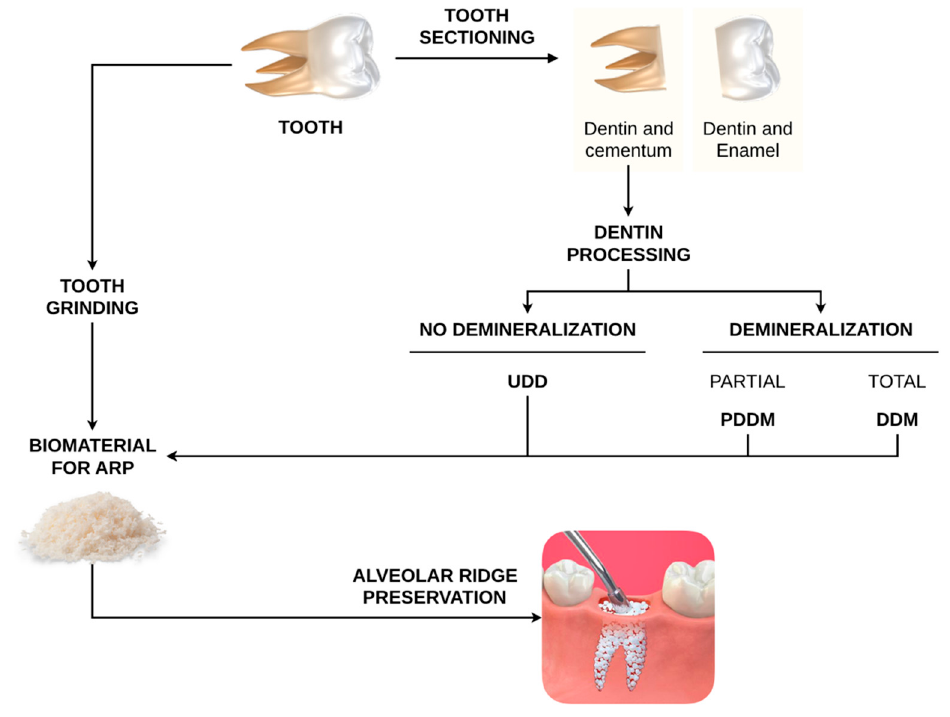
Figure 1. Schematic diagram explaining different dentin processing approaches. UDD—undemineralized dentin matrix; PDDM—partially demineralized dentin matrix; DDM—demineralized dentin matrix).